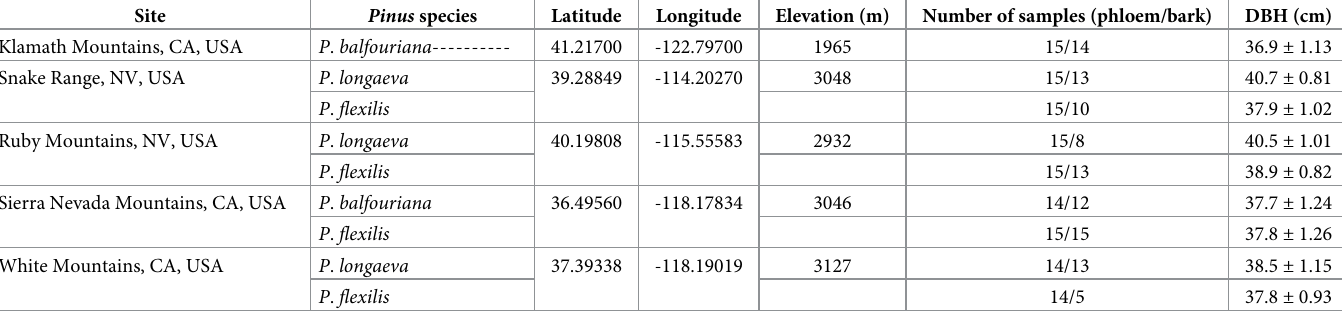
Table 1. Site locations (see Fig 1) and stand metrics including species sampled, number of phloem and bark samples analyzed, and mean ± standard error of DBH (diameter breast height). Site Snake Range, NV,